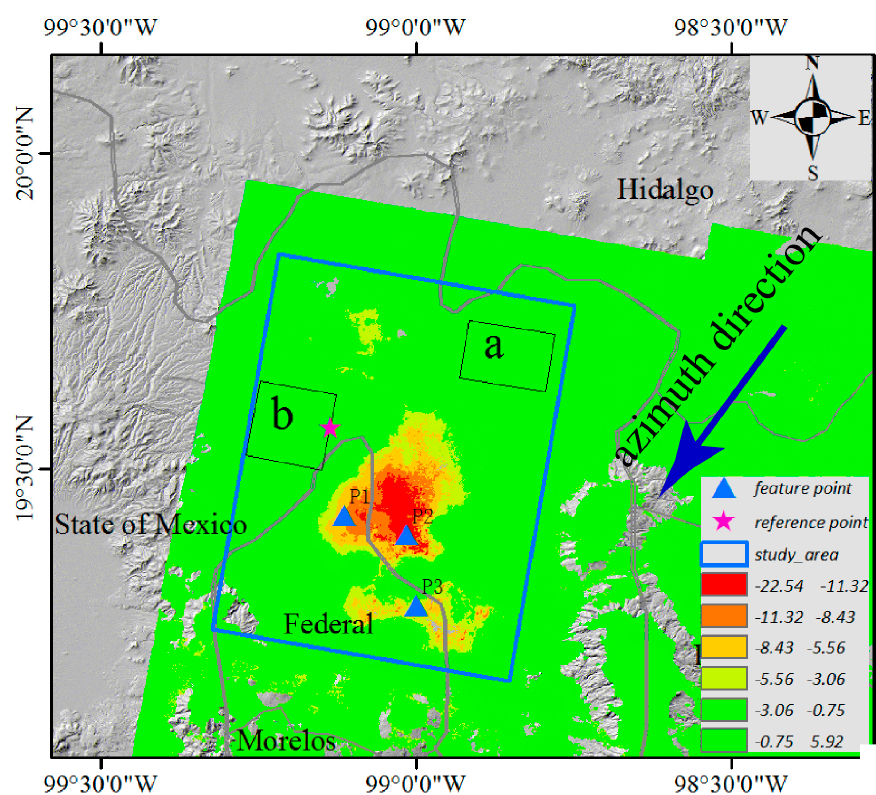
Figure 4. Subsidence velocity derived by the stacking method (unit: cm/year), where the black rectangles represent stable areas, the purple star indicates the reference point, the blue triangles are the feature points for the time-series deformation analysis and the blue box is the study area, the grey line indicates the administrative boundaries.